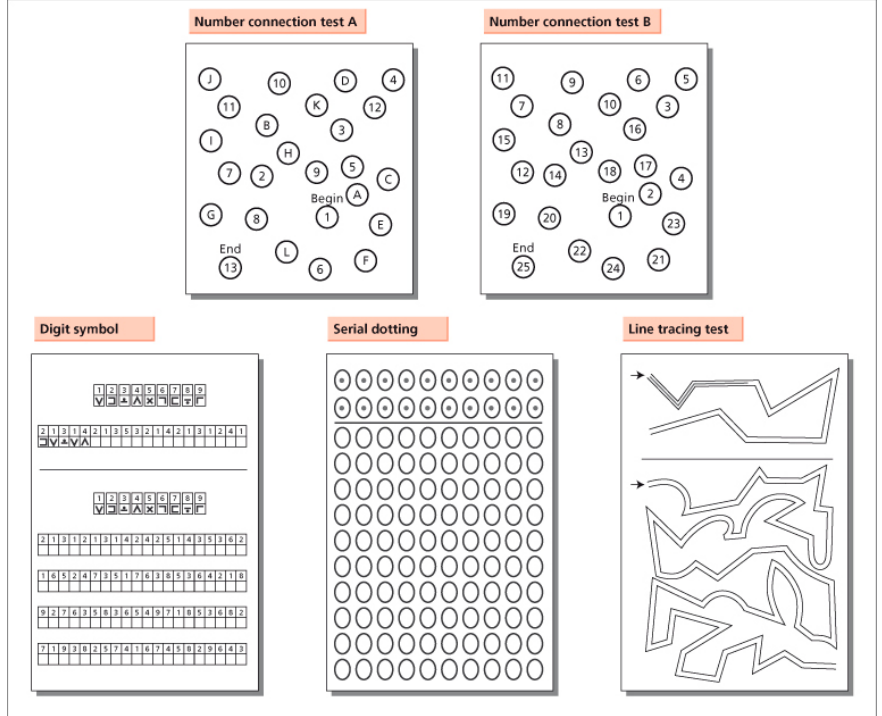
Figure 1. The psychometric hepatic encephalopathy score (PHES).